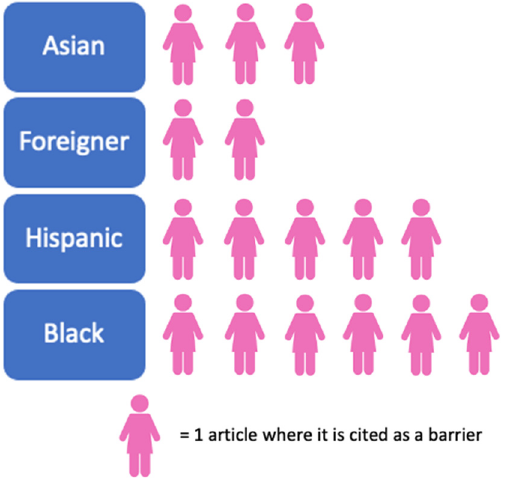
Figure 1. Barriers reported to race and/or ethnicity, according to number of articles. Black race/ethnicity is the one mentioned in the highest number of articles as a barrier to adherence ( n = 6), followed by Hispanic ( n = 5), Asian ( n = 3) and foreign status ( n = 2). If we focus on the data of non-Hispanic white women compared with Black women, the latter show a lower frequency of screening mammography [19], a higher probability of